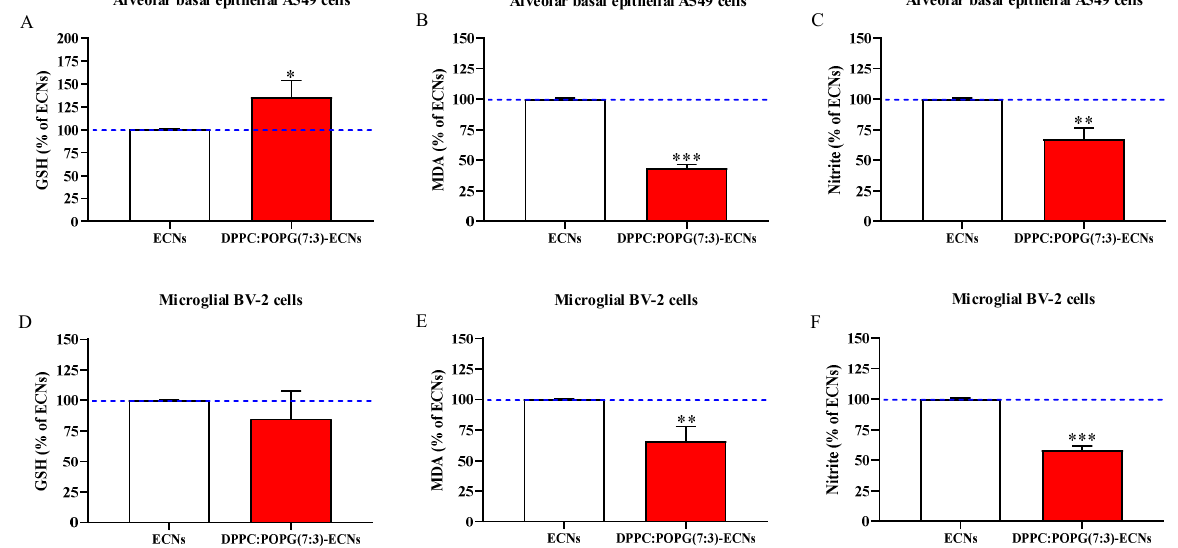
Figure 5. GSH, MDA, and nitrite in A549 ( A – C ) and BV-2 ( D – F ) cells following 24 h of ECNs (2 µg/mL) challenge without and with the LS DPPC:POPG(7:3) (indicated as DPPC:POPG(7:3)-ECNs). ECNs = engineered carbon nanodiamonds; DPPC = dipalmitoyl phosphatidylcholine; POPG = 1-palmitoyl-2-oleoyl-sn-glycero-3-phospho-(1′-rac-glycerol); GSH = reduced glutathione; MDA = malondialdehyde. Data are the mean of three independent experiments and are expressed as the percent variation with respect to the quantity of GSH, MDA, or nitrite recorded in ECNs-treated cells. Standard deviations are represented by vertical bars. * Significantly different from ECNs-treated cells, p < 0.05; ** Significantly different from ECNs-treated cells, p < 0.01; *** Significantly different from ECNs-treated cells, p < 0.001.